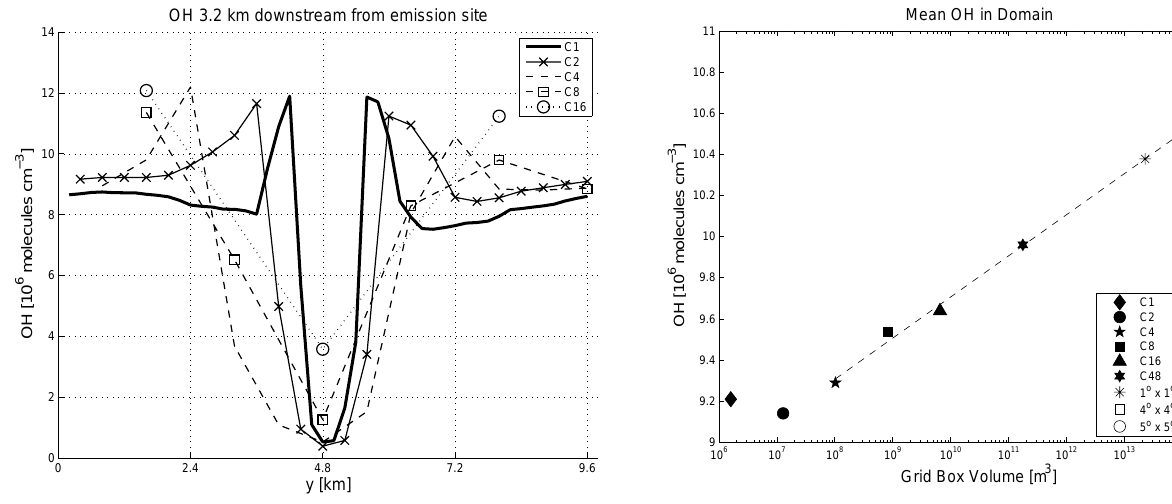
Fig. 4. OH concentrations across the plume on the lowest vertical level 3.2km downstream of the emission source for four different resolution runs at noon (local time) on day 2.